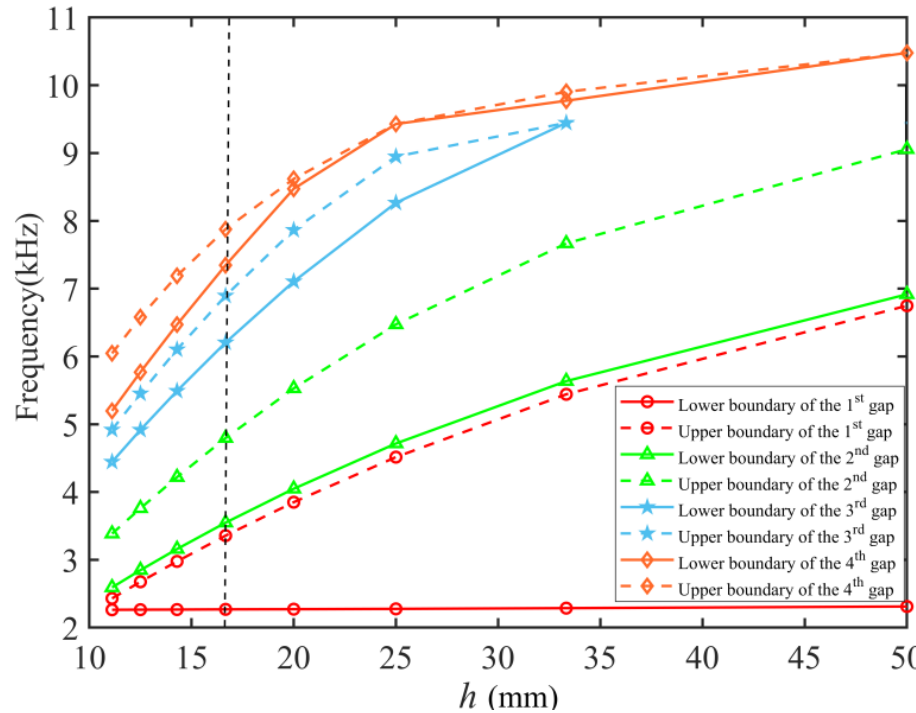
Figure 12. Effects of thickness on the upper and lower boundaries of each bandgap.